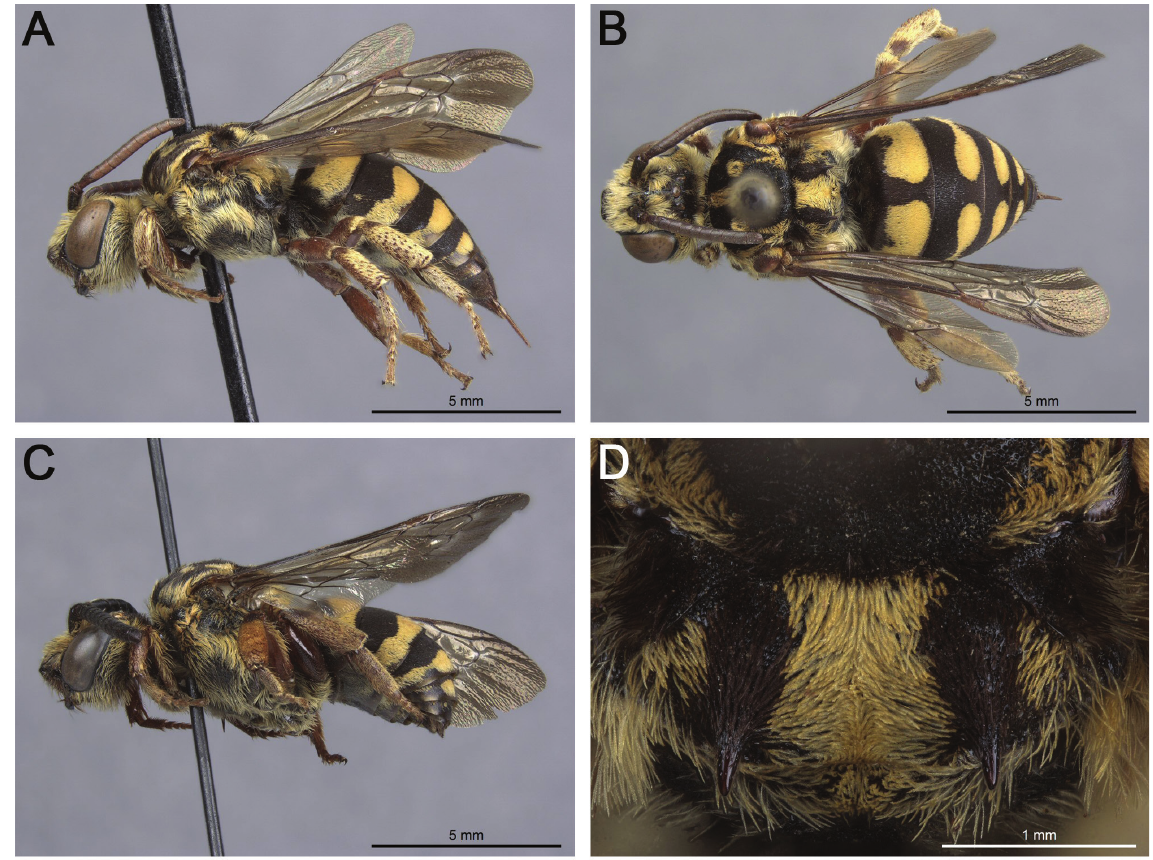
Fig. 3. Brachymelecta alayoi (Michener, 1988). A–B, D: female (JAG); C: male (JAG). A . Habitus, lateral view. B . Habitus, dorsal view. C . Habitus, lateral view. D . Axillae and mesoscutellum, dorsal